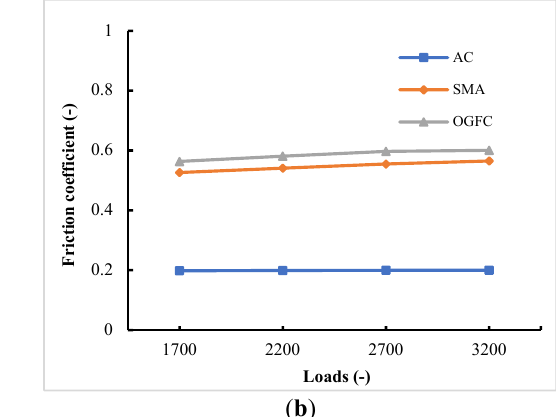
Figure 11. Variation laws of friction coefficients with loads. ( a ) Tire free rolling state; ( b ) tire braking state.